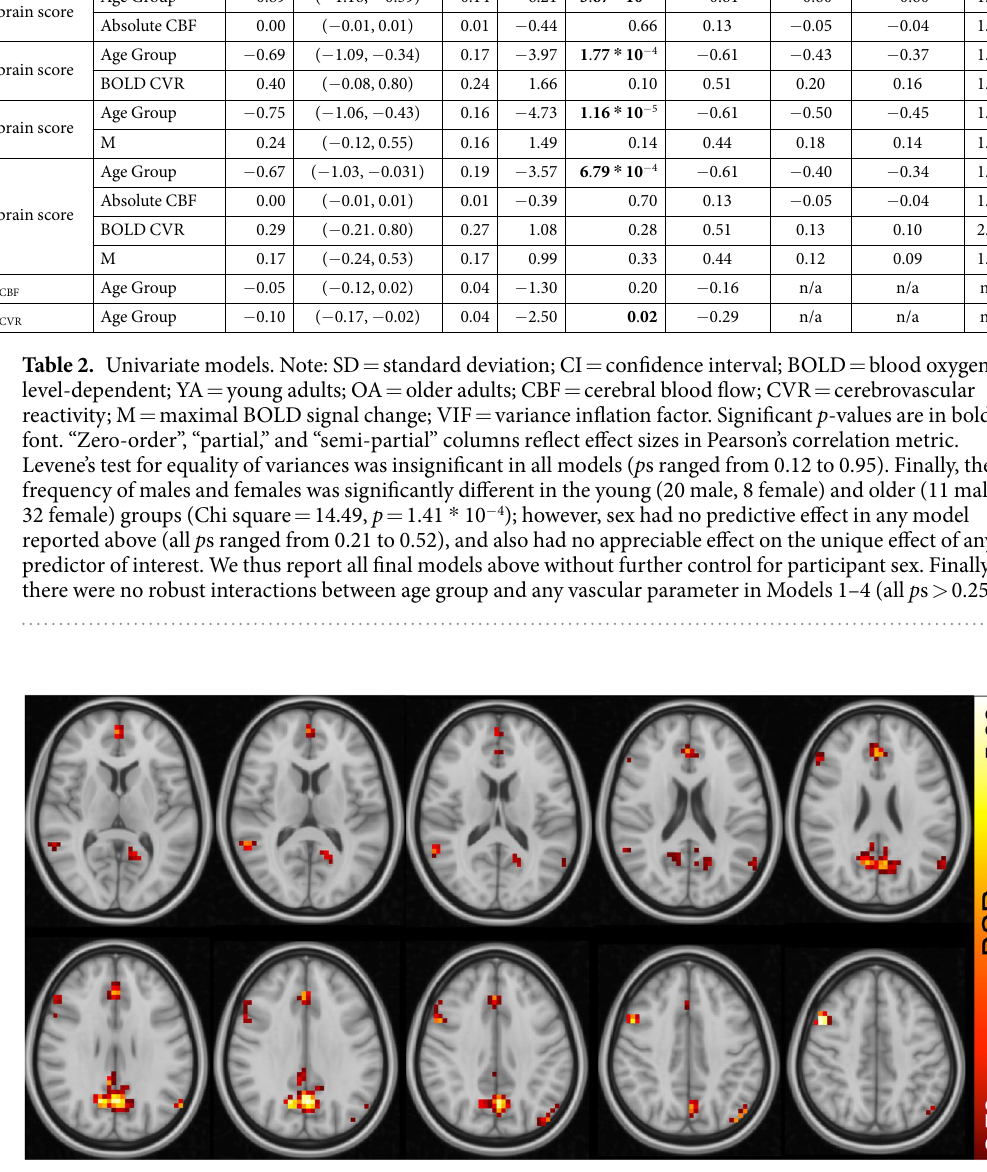
Figure 2. Regions expressing greater SD BOLD in younger vs. older adults. Note: BSR = bootstrap ratio. From top left, slices are shown from Z = 8 to Z = 44 in 4 mm